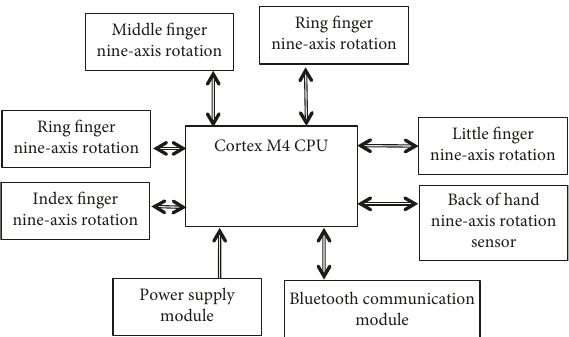
Figure 1: System framework of hardware platform of virtual reality interactive